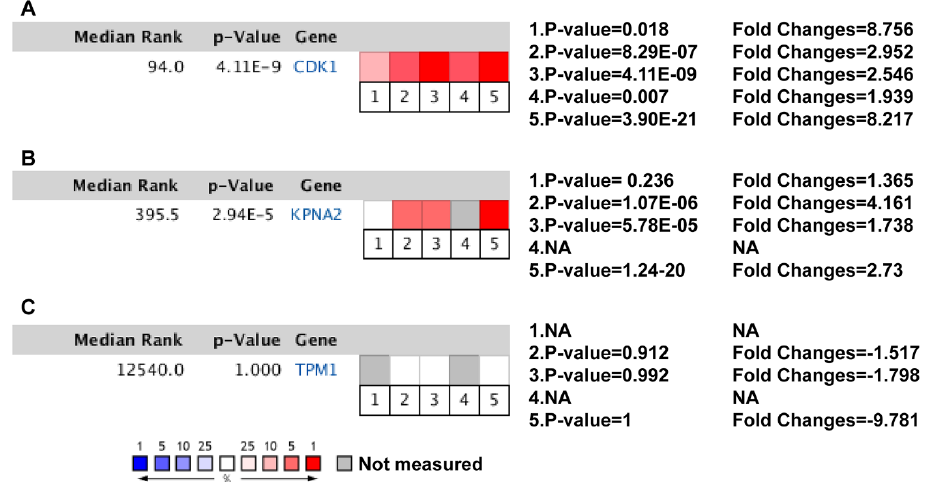
Figure 9. Oncomine meta-analysis of ( A ) CDK1, ( B ) KPNA2, and ( C ) TPM1 expression levels in BCa vs. no-cancerous bladder tissue. Heat maps of CDK1, KPNA2, and TPM1 gene expression in clinical BCa samples vs. noncancerous tissues. Clinical BCa samples are infiltrating bladder urothelial carcinoma. Data included from (1) Blaveri et al., Clin Cancer Res , 2005, invasive cancer samples n = 51, normal bladder samples n = 3 [33]. (2) Dyrskjot et al., Cancer Res , 2004, invasive cancer samples n = 13, normal bladder samples n = 14 [34]. (3) Lee et al., J Clin Oncol , 2010, invasive cancer samples n = 62, normal bladder samples n = 10 [35]. (4) Modlich et al., Clin Cancer Res , 2004, invasive cancer samples n = 20, normal bladder samples n = 4 [36]. (5) Sanchez-Carbayoet al., J Clin Oncol , 2006, invasive cancer samples n = 72, normal bladder samples n = 52 [37].